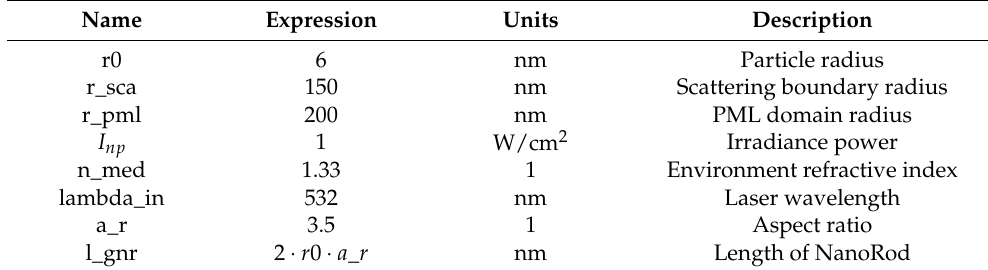
Table 1. Summary of the parameters introduced for the NanoRod